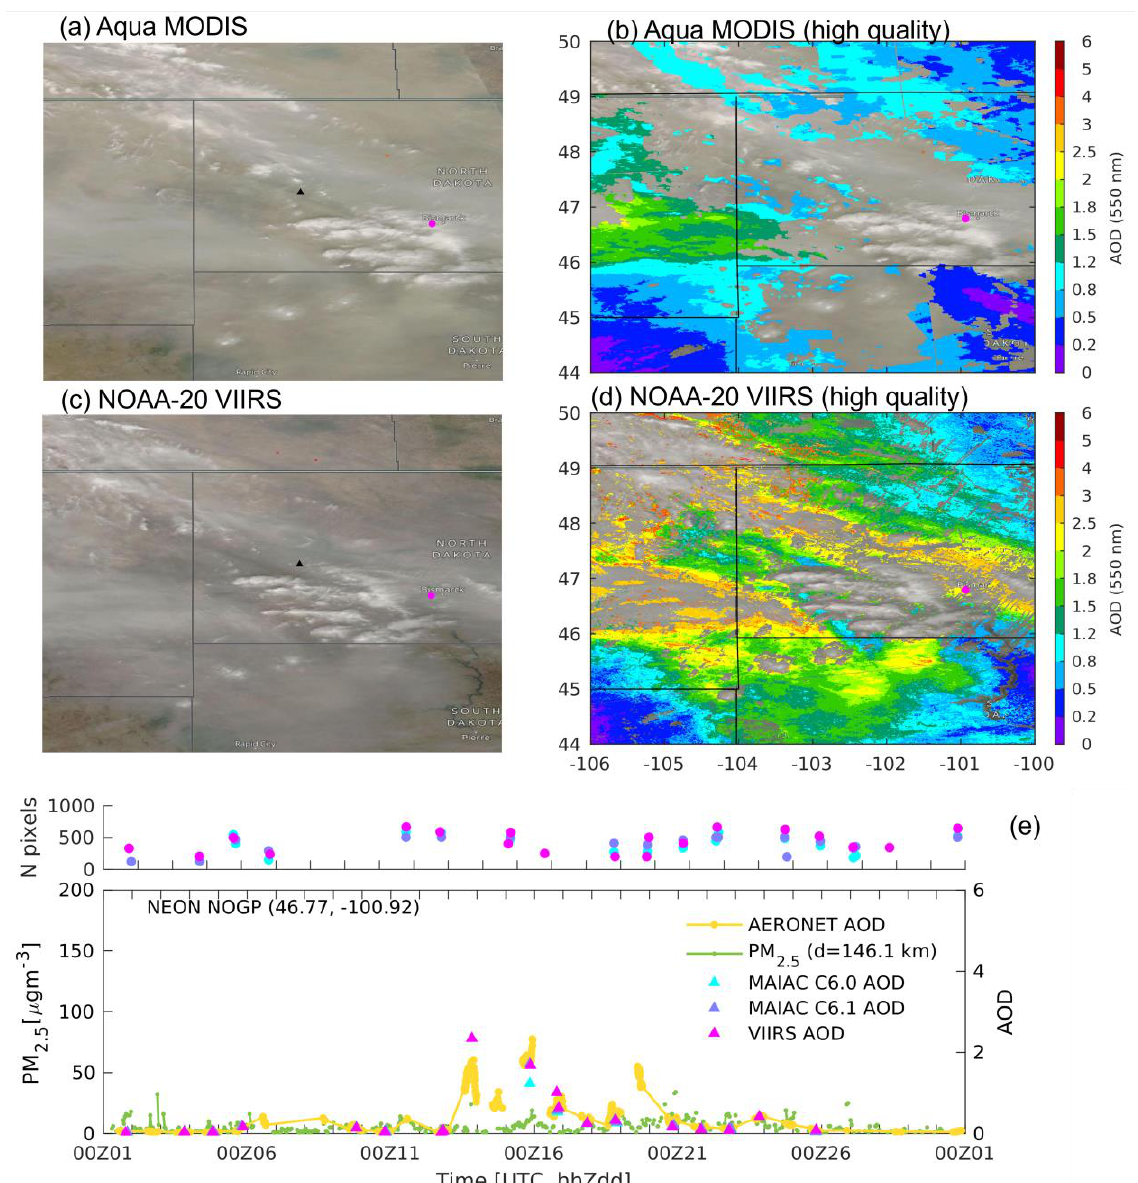
Figure 9. Similar to Figure 6 but for 13 September 2020 ( a – e ). The magenta dot stands for location of the AERONET station NEON NOGP. The satellite AODs have been plotted on top of the true color images.